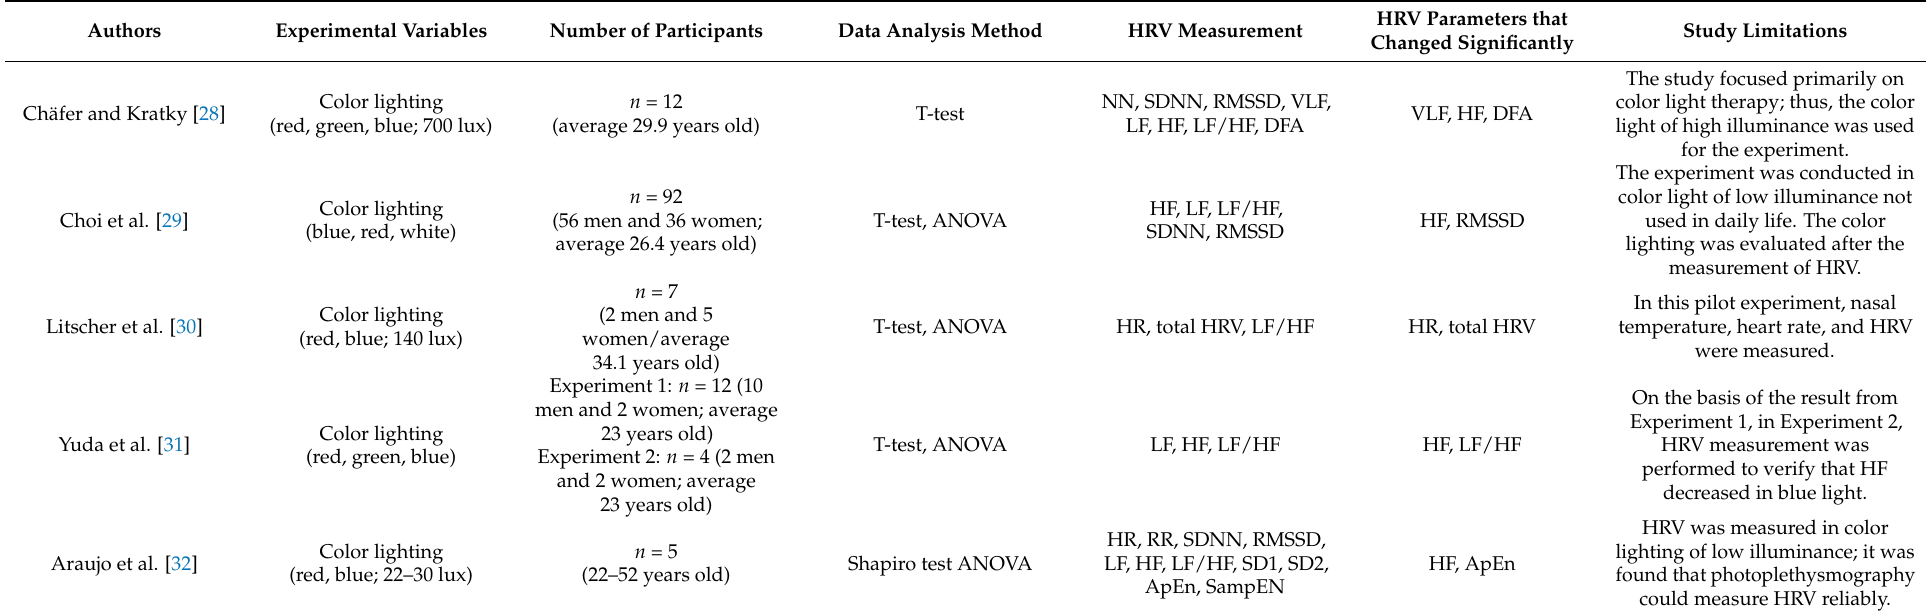
Table 2. Studies of short-term HRV measurement with color as the experimental